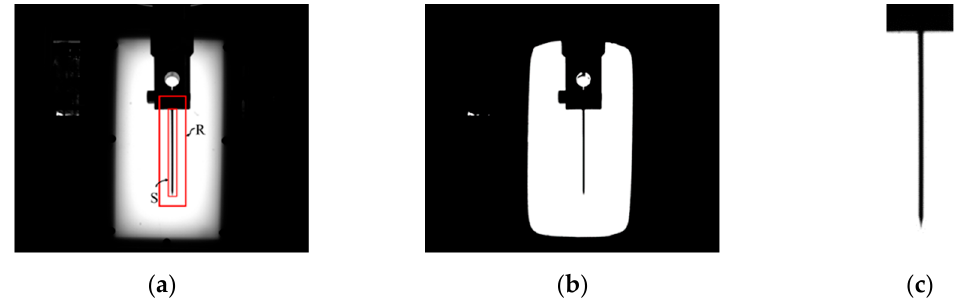
Figure 3. ( a ) Original image of the cutting blade; ( b ) binary image; ( c ) ROI image.